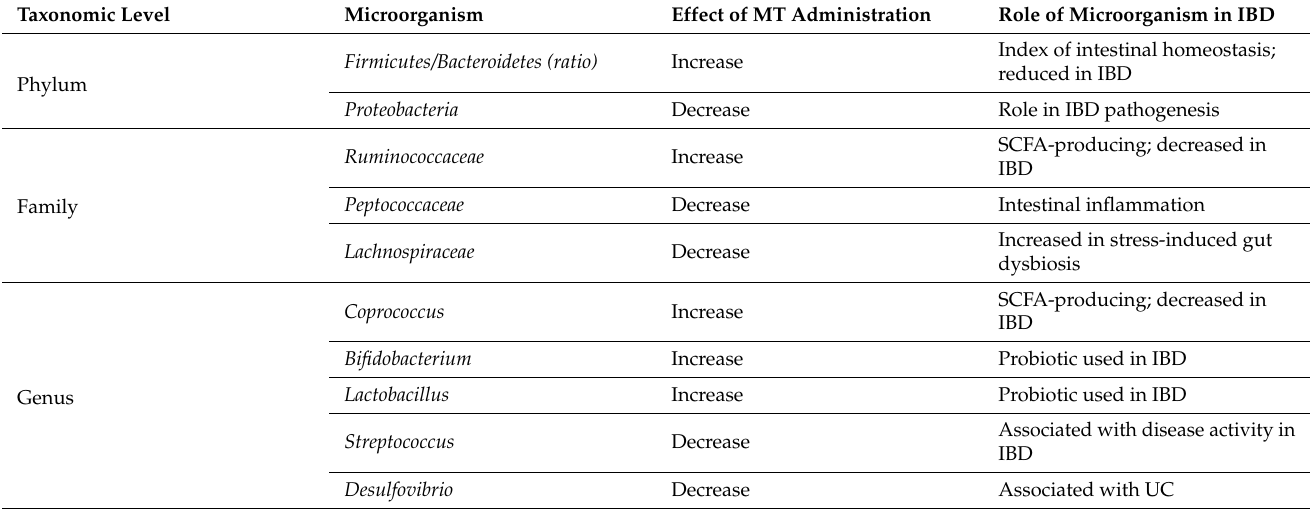
Table 2. Impact of MT administration on gut microbiota composition in preclinical models of